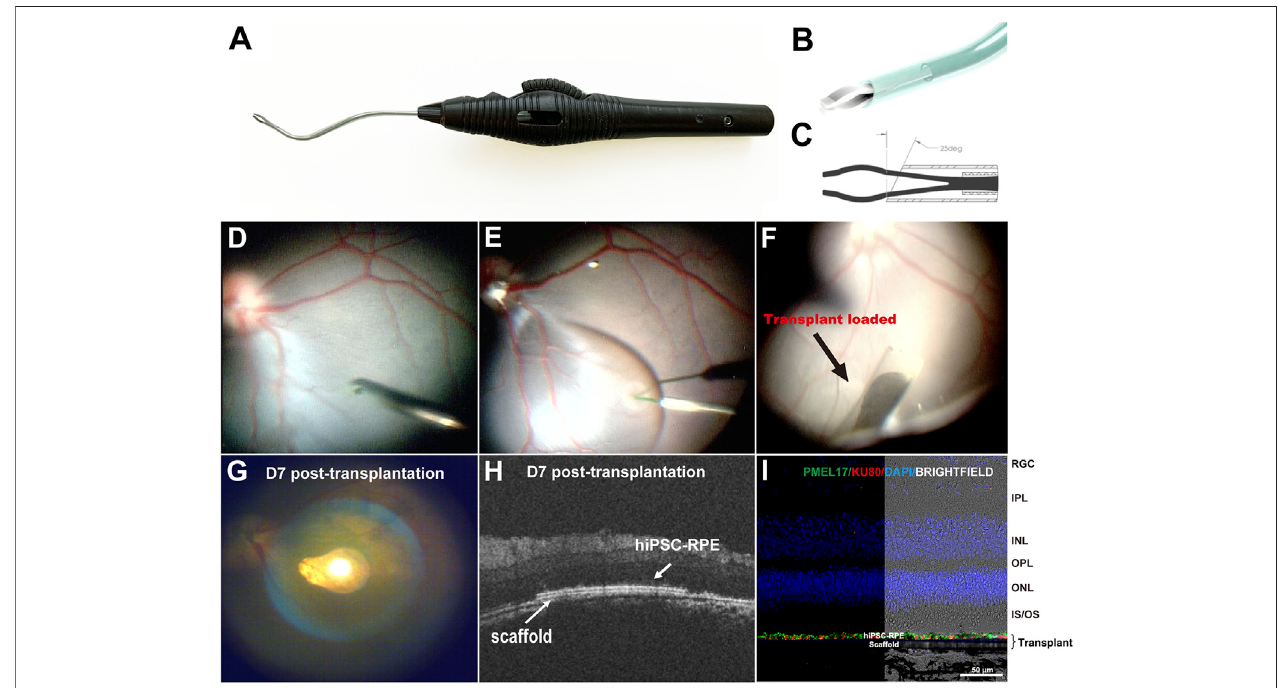
FIGURE 4 | Surgical delivery instrument and outcome of subretinal delivery of the hiPSC-RPE transplants. (A) Lateral view of the transplantation device. (B) The benttranslucentTe fl oncannulaenablesthevisualizationofthetransplantduringloadingandreleasing. (C) A25-degreetipallowsthetransplanttorollconcavelyintothe lumen of the Te fl on cannula. (D) During the transplantation surgery, a standard pars plana vitrectomy was performed, (E) A localized retinal bleb was created using a Polytip Cannula 25/38G, and (F) hiPSC-RPE transplant was delivered within the subretinal space with our surgical delivery instrument. (G – I) A week after transplantation surgery, (G) fundus photo showed the hiPSC-RPE transplant properly localized at the target position; (H) OCT demonstrated that the transplant laid fl at betweenthehostneuralretinaandRPEwithnoundesiredinjuriesobservedinthehostretina,RPEandchoroid; (I) Immuno fl uorescencefordetectionofhumanPMEL17 and human nuclear Ku80 proteins showed a continuous human RPE monolayer covering the polyester membrane scaffold; no human cells were found outside the scaffold. RGC, retinal ganglion cell; IPL, inner plexiform layer; INL, inner nuclear layer; OPL, outer plexiform layer; ONL, outer nuclear layer; IS/OS, inner segments/outer segments; hiPSC-RPE, human induced pluripotent stem cell-derived retinal pigment epithelial cells.